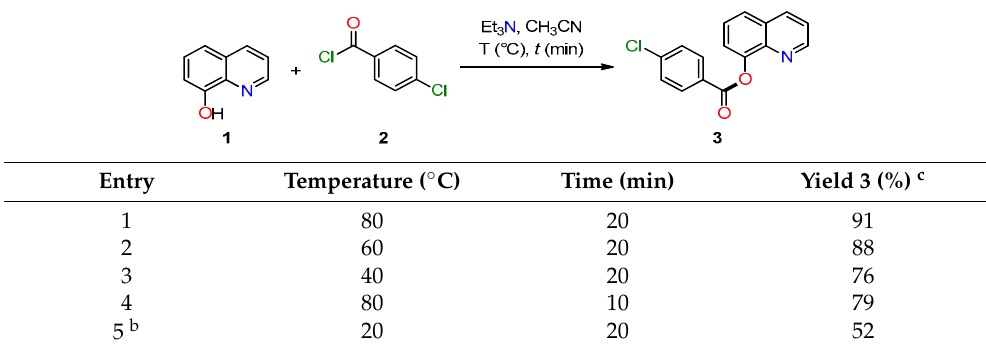
Table 2. Synthesis of the quinolin-8-yl 4-chlorobenzoate ( 3 ) a .